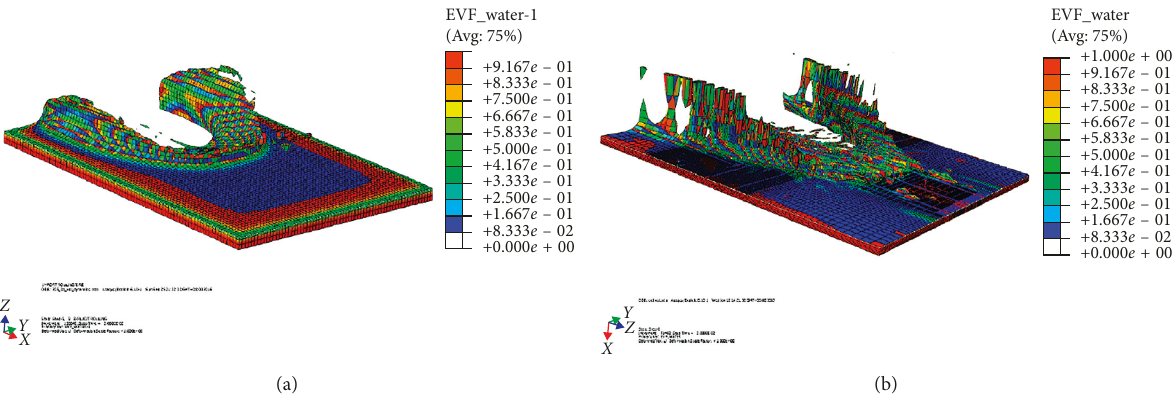
Figure 3: Comparison of flow trace: (a) tire rolling model and (b) flow model.